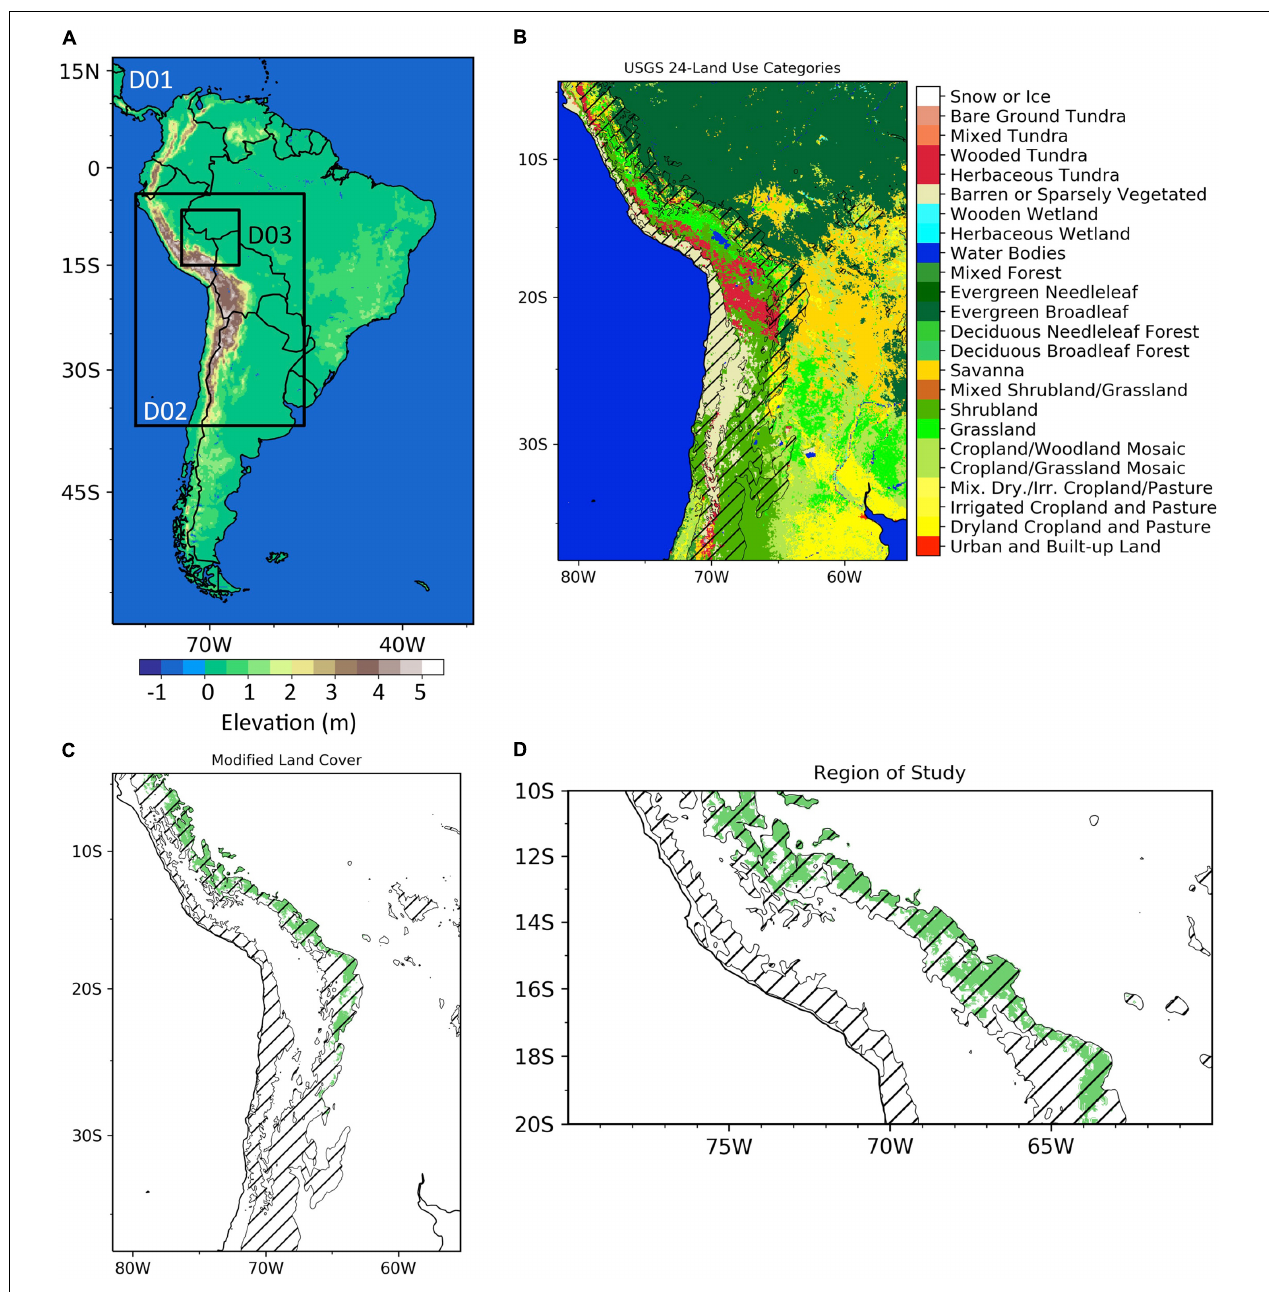
FIGURE 1 | (A) Domain setup for numerical simulations with 3 nested domains with gradually smaller grid spacing: D01 (18 km), D02 (6 km), and D03 (1.2 km). (B) Default USGS 24-land use categories in WRF version 4.1 for (D02, 18 km) and (C) modified land use category shown with a green shade. The hashed contour areas show the elevations between 500 and 3,500 m. (D) Zoom of (B) over the region of